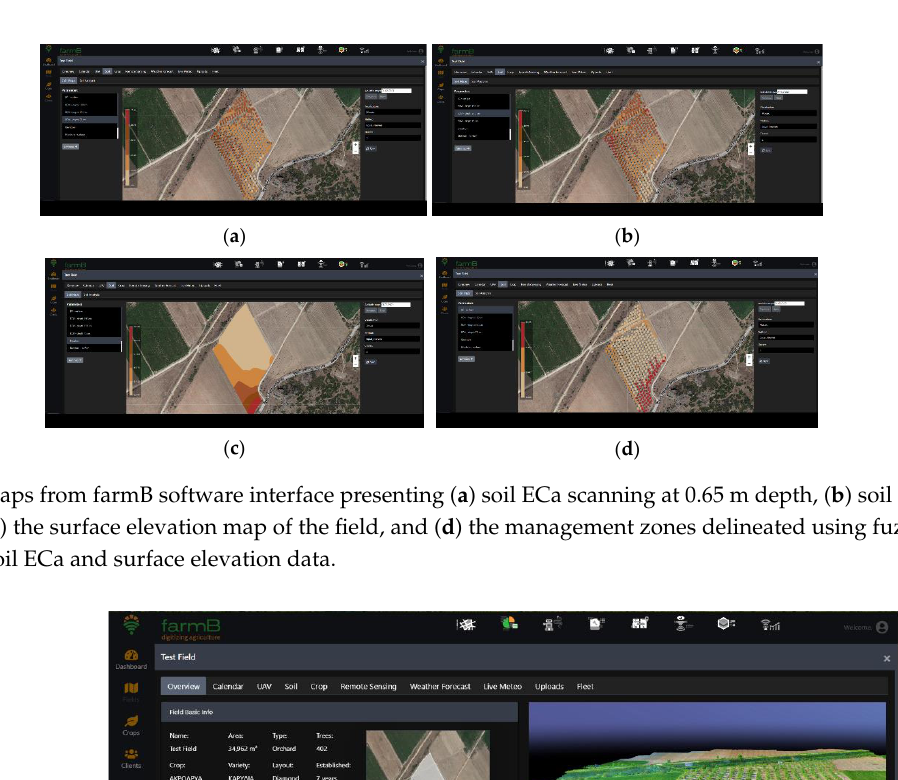
Figure 5. Diagram of the fuzziness Performance Index (FPI) and Normalized Classification Entropy (NCE) for delineating the orchard into 2 – 6 management zones.